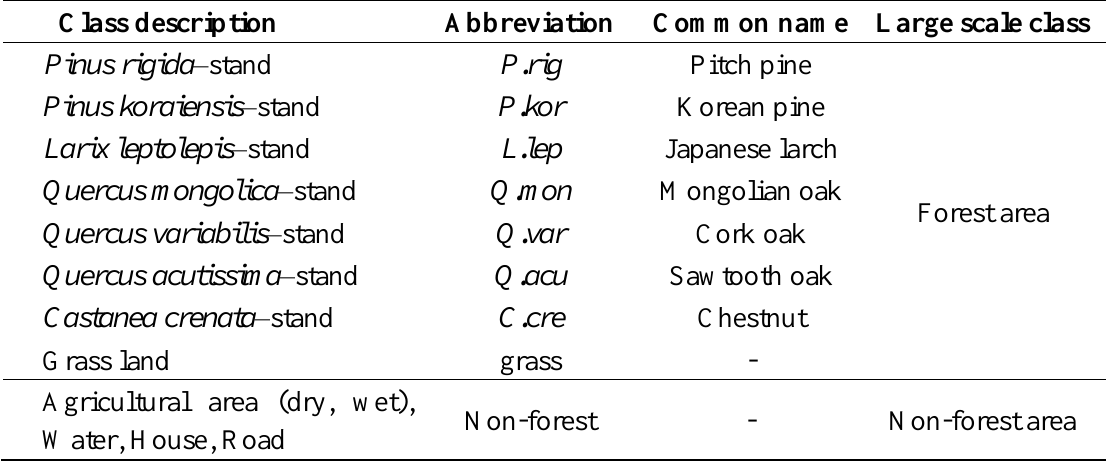
Table 1. Classification schema for preparing forest cover